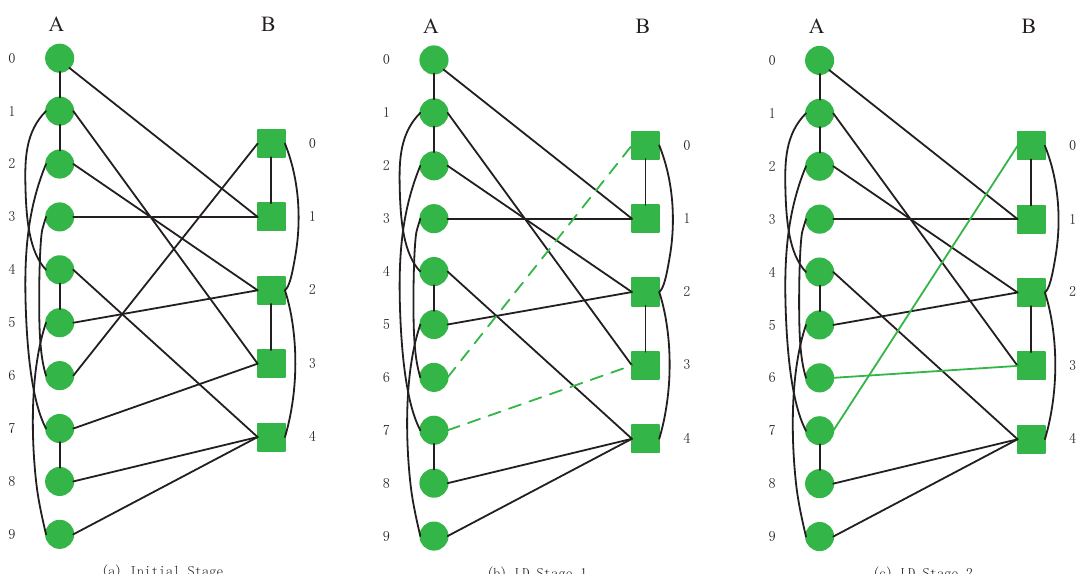
Figure 3. The entire low degree (LD) swapping inter-links strategy processes in interdependent